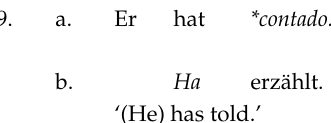
Figure 6. Structure of the French subordinate clause.